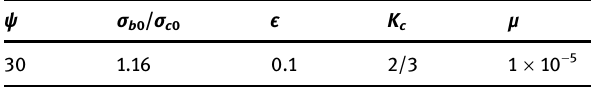
Figure 4: Model of the steel – polypropylene HFRC.